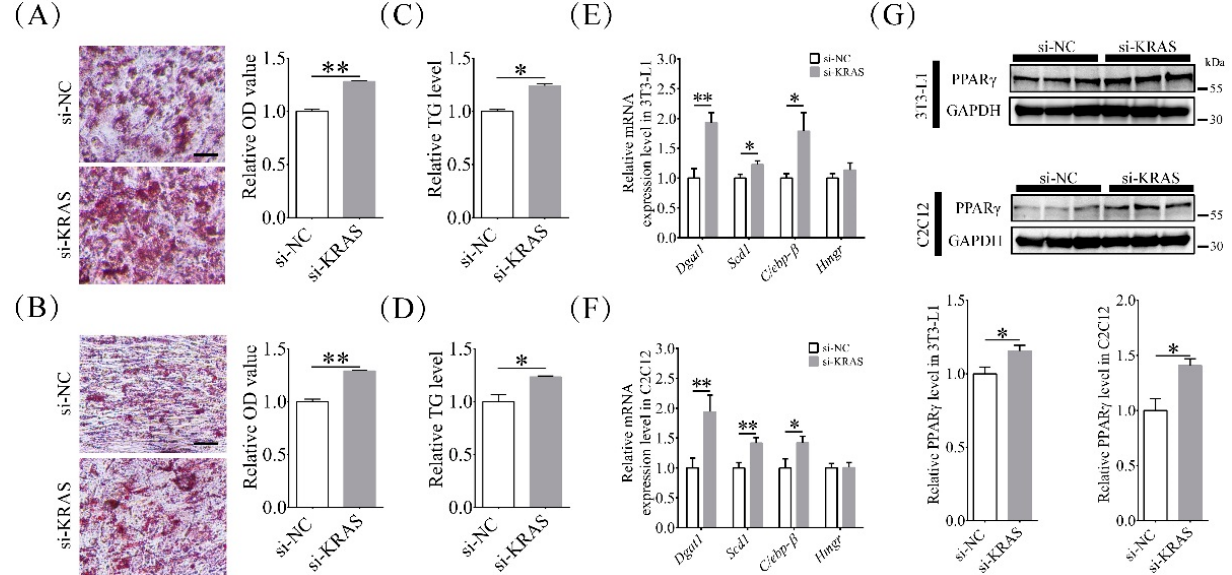
Figure 2. Effects of KRAS on adipogenic differentiation and lipid accumulation in 3T3-L1 and C2C12 cells. ( A , B ) Representative oil red O (ORO) staining images and relative ORO optical density (OD) value (OD 520nm values to total protein level) changes in 3T3-L1 and C2C12 cells after induction of adipogenic differentiation with or without KRAS inhibition. The ORO staining images suggested that the inhibition of KRAS enhanced the lipid accumulation after induction of adipogenic differentiation in 3T3-L1 and C2C12 cells. Scale bar = 50 µ m. Significant differences are represented with ** ( p < 0.01). ( C , D ) Relative triglyceride (TG) level changes in 3T3-L1 and C2C12 cells after induction of adipogenic differentiation with or without KRAS inhibition. Significant differences are represented with * ( p < 0.05). ( E , F ) mRNA expression of diacylglycerol O-acyltransferase 1 ( Dgat1) , stearoyl-coenzyme A desaturase 1 ( Scd1) , CCAAT/enhancer binding protein beta (C/ebp- β ) , and 3-hydroxy-3-methylglutaryl-coenzyme A reductase (Hmgr) in 3T3-L1 and C2C12 cells before induction of adipogenic differentiation. Significant differences are represented with * ( p < 0.05) and ** ( p < 0.01). ( G ) Relative peroxisome proliferator-activated receptor γ (PPAR γ ) protein level changes in 3T3-L1 and C2C12 cells after induction of adipogenic differentiation. Significant differences are represented with * ( p <